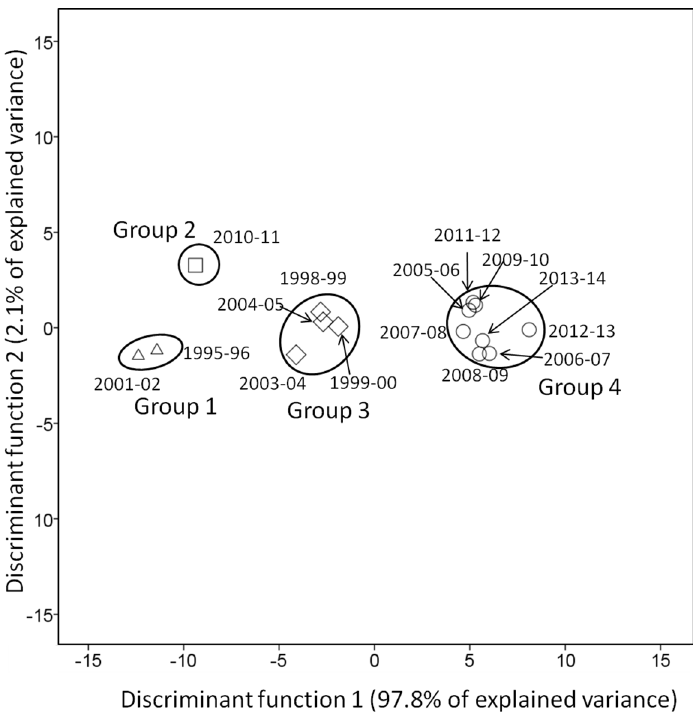
Fig 7. Stepwise linear discriminant analysis (SLDA) biplots illustrating a pattern of similarity in weather parameters between different seasons. Numbers in the biplots represent the seasons for weather parameters and wine rotundone